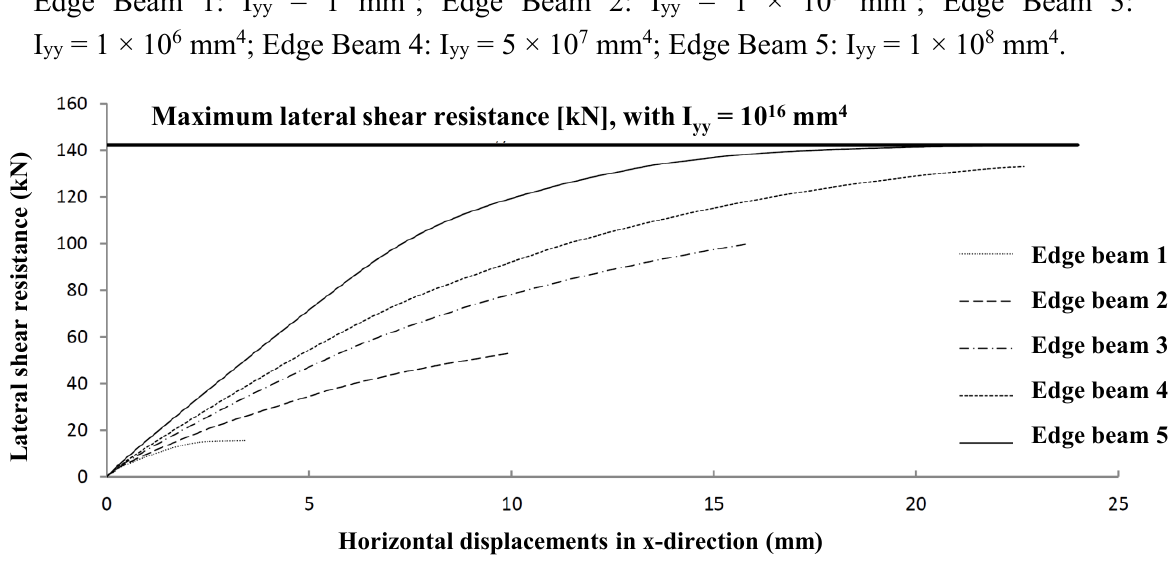
Figure 20. Lateral shear resistance for edge beams differing in second moment of inertia I yy : Edge Beam 1: I yy = 1 mm 4 ; Edge Beam 2: I yy = 1 × 10 5 mm 4 ; Edge Beam